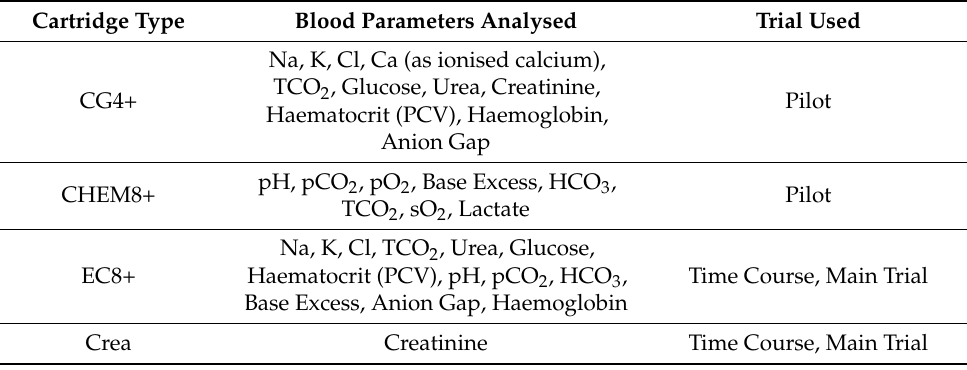
Table 1. Blood analysis parameters by